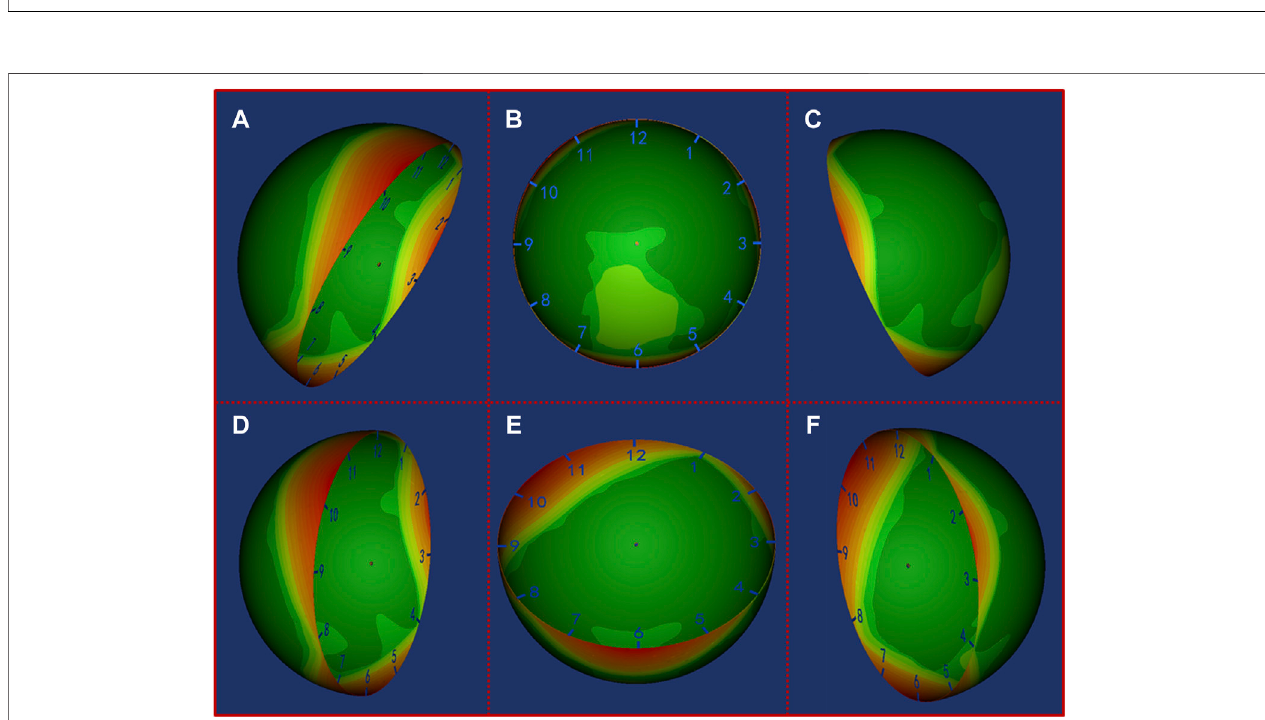
FIGURE4| DistributionmapoftheuncoveredareainAAOSIgroup.Greentoredindicatesthattheuncoveredfrequencyrangesfromlowtohigh. (A) Frontviewof thepelvis, (B) openingorientationviewofthecup, (C) Backviewofthepelvis, (D) Lateralviewofthecupfromfronttoback, (E) Lateralviewofthecupfrombottomtotop, (F) Lateral view of the cup from back to front.